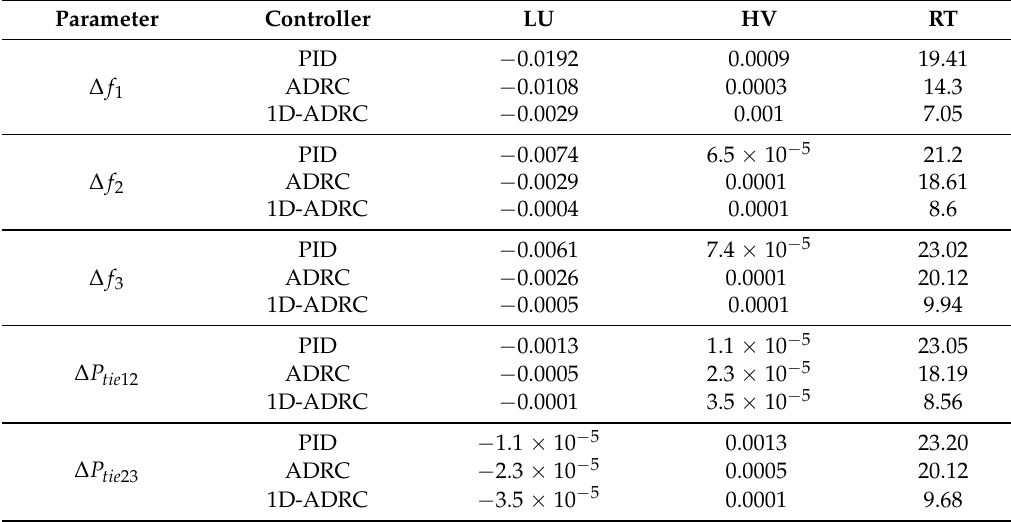
Figure 5. Response comparison of PID, conventional-ADRC, 1D-ADRC controllers. Table 2. Observations of Figure